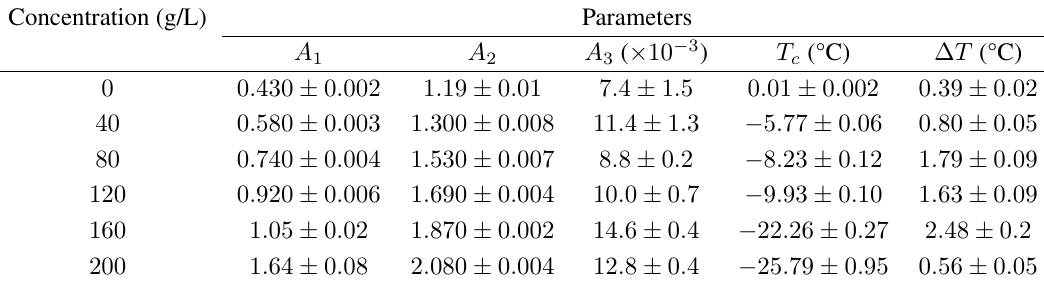
Table 1. Fitted parameters of curves of figure 5.